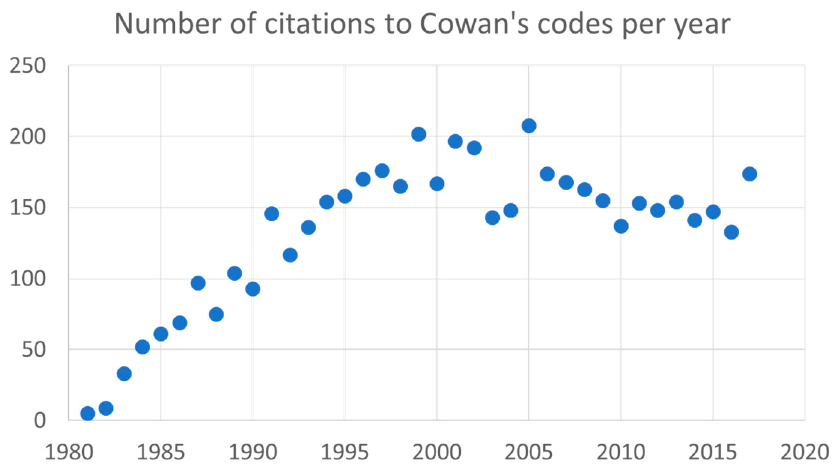
Figure 3. Number of citations to Cowan’s book [1] and computer codes based on it per year (per the same source as Figure 2).